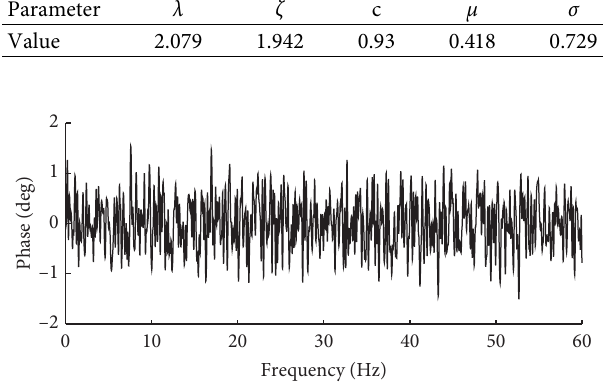
Figure 9: Phase spectrum of artificial multipoint seismic wave.